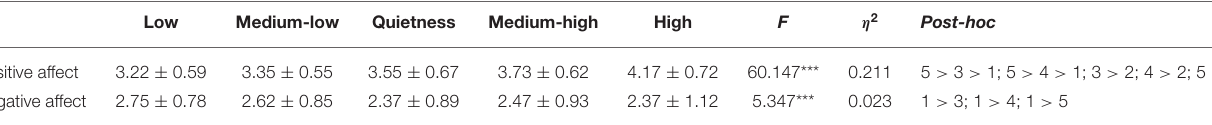
TABLE 5 | Differences in positive and negative affect across latent profiles ( M ± SD